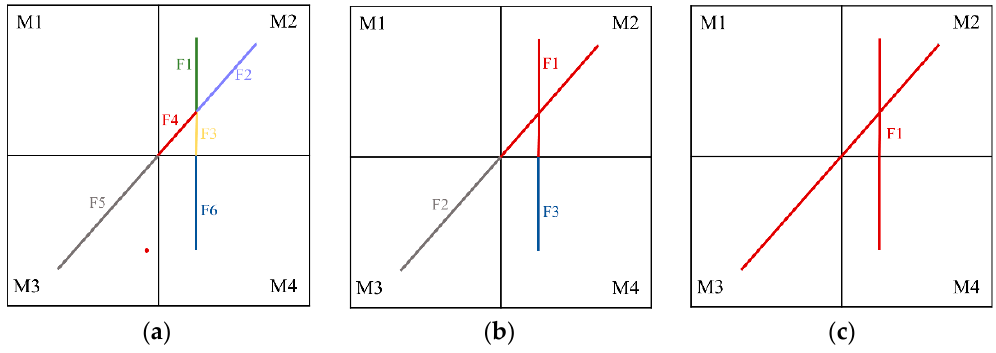
Figure 2. Explanation of the integrally embedded discrete fracture model (iEDFM) gridding: ( a ) EDFM gridding method; ( b ) iEDFM gridding method I—discretizing by matrix element boundaries; and ( c ) iEDFM gridding method II—taking the intersecting fracture group as one element.